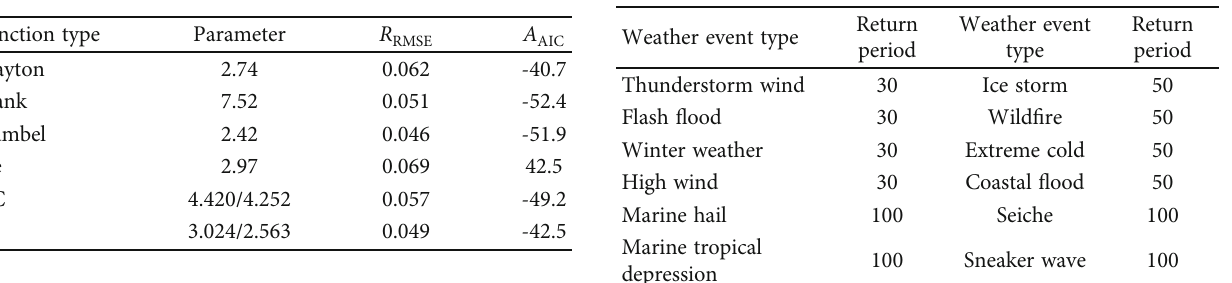
∗ Note: the boldface in the table is the optimal marginal distribution function. Table 2: Three-variable joint distribution of weather events.